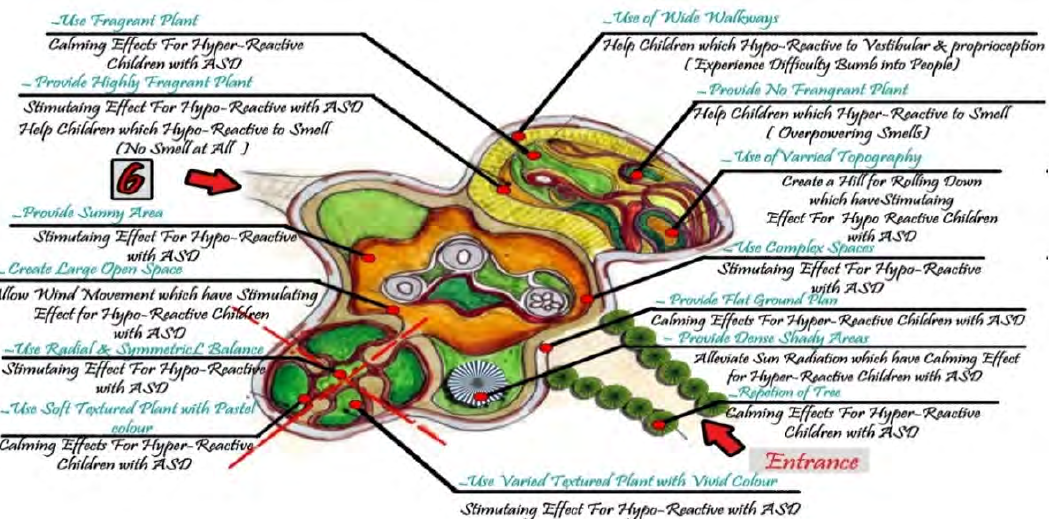
Figure 23. Show thedesign consideration for the “Natural Trail” zone C